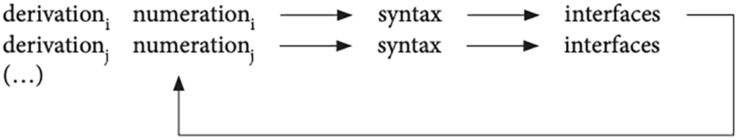
The architecture of derivation layering.